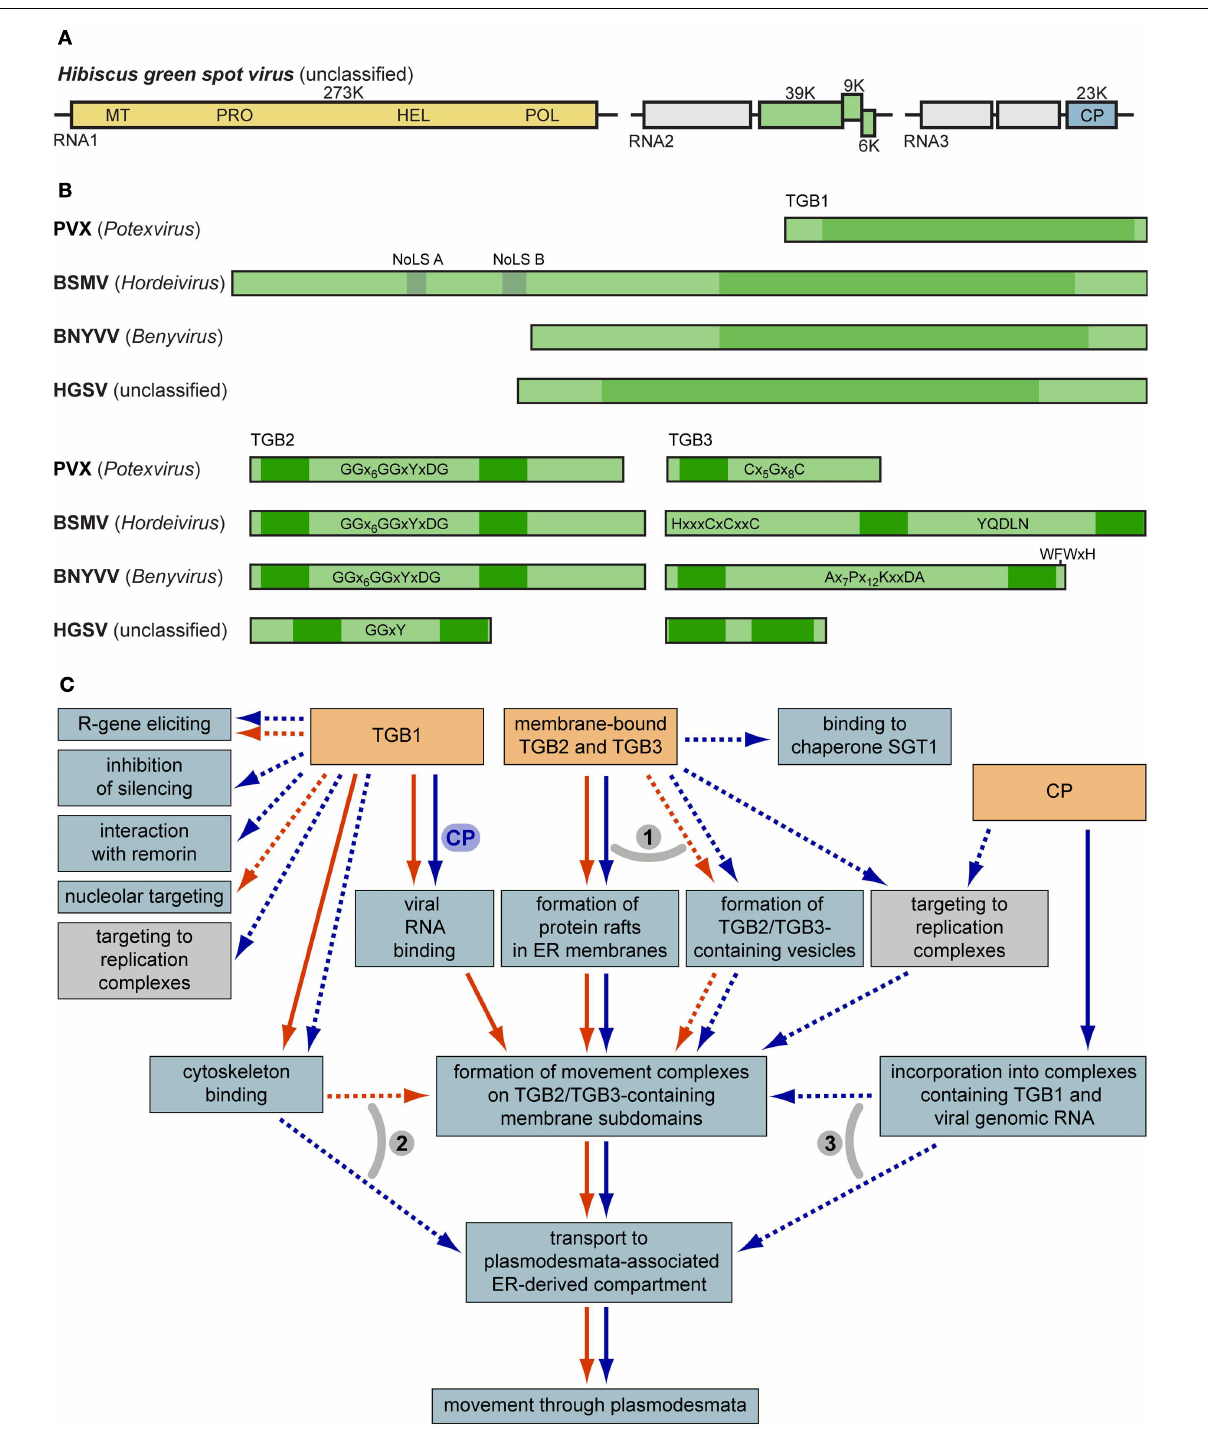
FIGURE 1 | (A) Genome organization of the newTGB-containing virus HGSV. Boxes represent genome-encoded open reading frames. Replicase gene domains are shown in the yellow box: MT, methyltransferase; PRO, protease; HEL, RNA helicase; POL, RNA-dependent RNA polymerase. Green boxes represent theTGB. Blue box specifies the viral coat protein (CP). (B) Molecular organization ofTGB1,TGB2, andTGB3 proteins. Nucleolar localization sequences and helicase domain regions ofTGB1 are shown above the BSMVTGB1. Characteristic signature sequences inTGB2 andTGB3 are